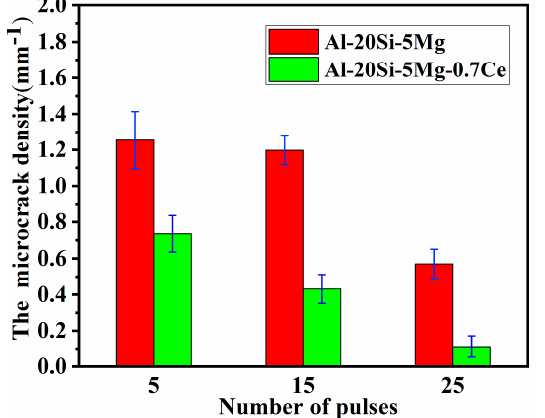
Figure 5. Relationship between microcrack density and pulse number of HCPEB-irradiated Al–20Si–5Mg and Al–20Si–5Mg–0.7Ce alloy surfaces.